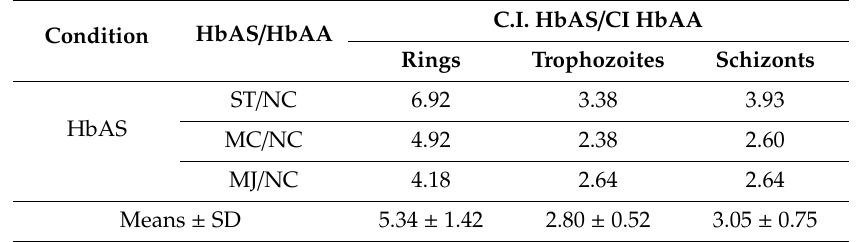
Table 2. Relative increasing in carbonyl index on the proteome of P. falciparum cultured in HbAS